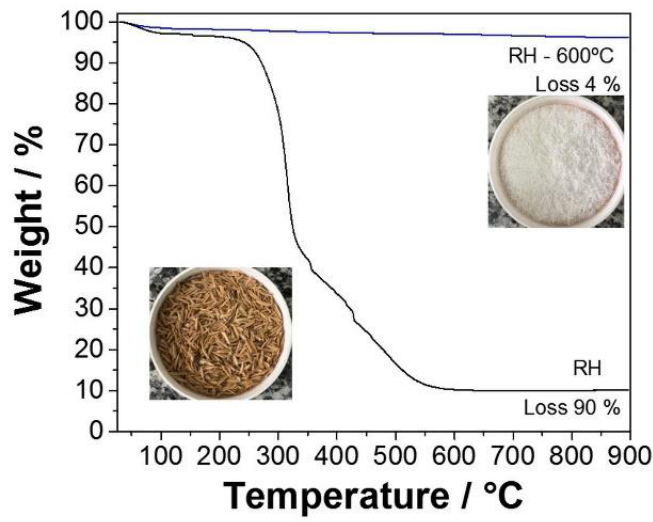
Figure 2. Thermogravimetric analysis of SiO 2 before and after rice husk (RH) treatment at 600 °C.